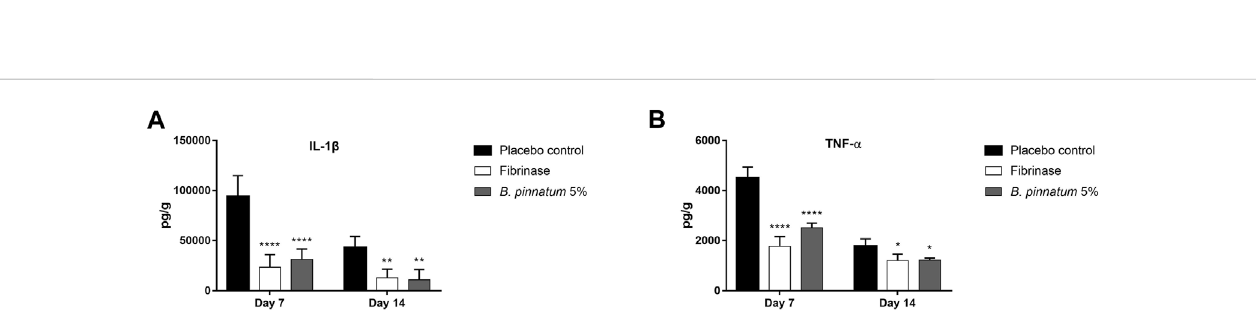
FIGURE 5 Effectoftopicaltreatmentwithagelformulationcontaining5%ofthe B.pinnatum extractonthelevelsofcytokines (A) IL-1 β and (B) TNF- α inskinwound biopsies.Resultsexpressedasmean±standarderrorofmean( n =5/group).**** p < 0.0001,** p < 0.01,and* p < 0.05 vs .placebocontrol byone-wayANOVA (Tukey ’ s